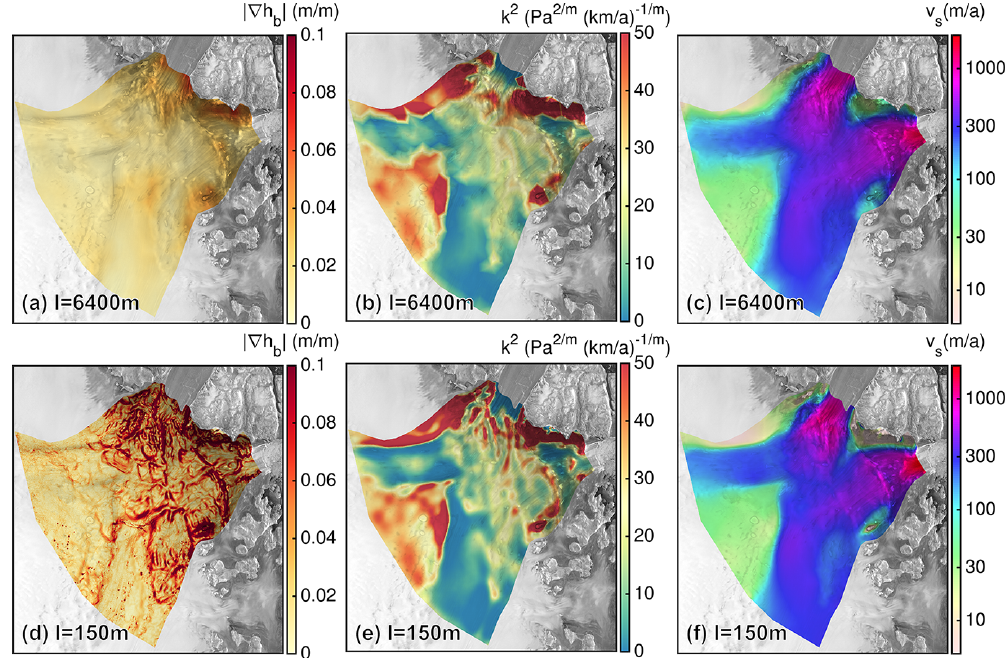
Figure 6. Overview of input parameters and simulation results of the outlet NEGIS region. The upper row shows (a) slope of bed topography, (b) basal friction coefficient for E = 1 and (c) simulated surface velocity with FS P1P1GLS weak and m = 3 for 6400m horizontal resolution. The lower rows show the same fields but for 150m horizontal resolution. Background image is a RADARSAT Mosaic (Joughin, 2015; Joughin et al.,